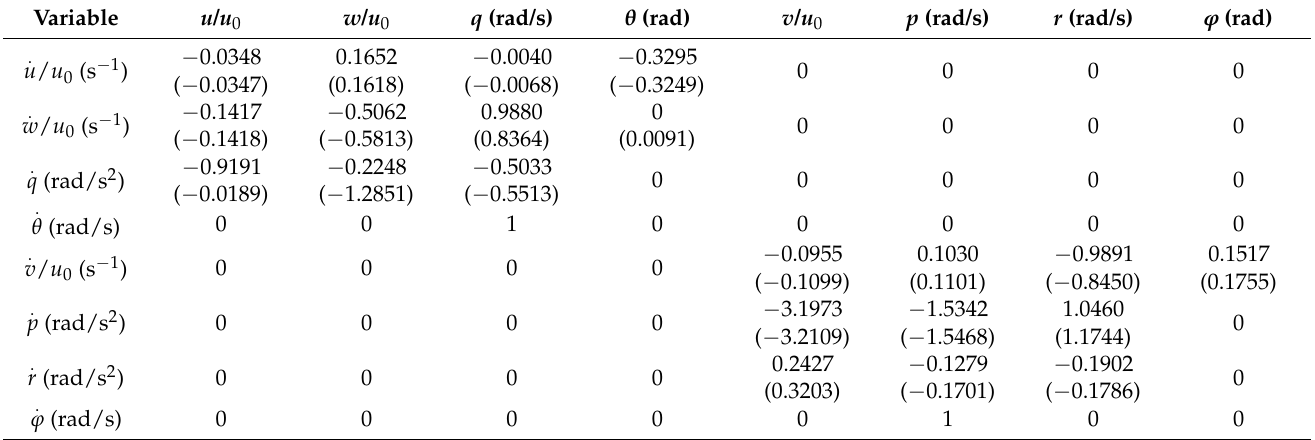
Table 17. CFD–RANS (extrapolated) 8 × 8 stability matrix for flight condition 10 in Tables 4 and 5.